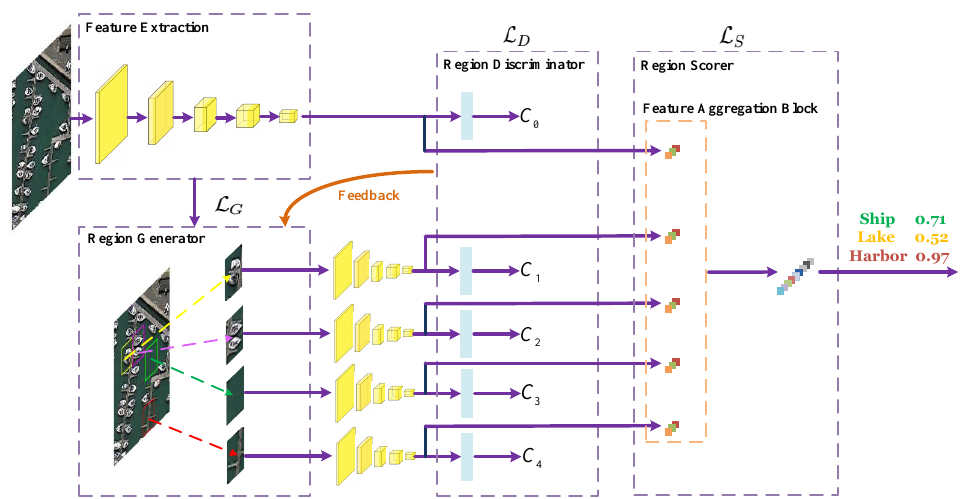
Figure 2. Flowchart of our ADRL-Net designed for remote sensing image classification ( N =